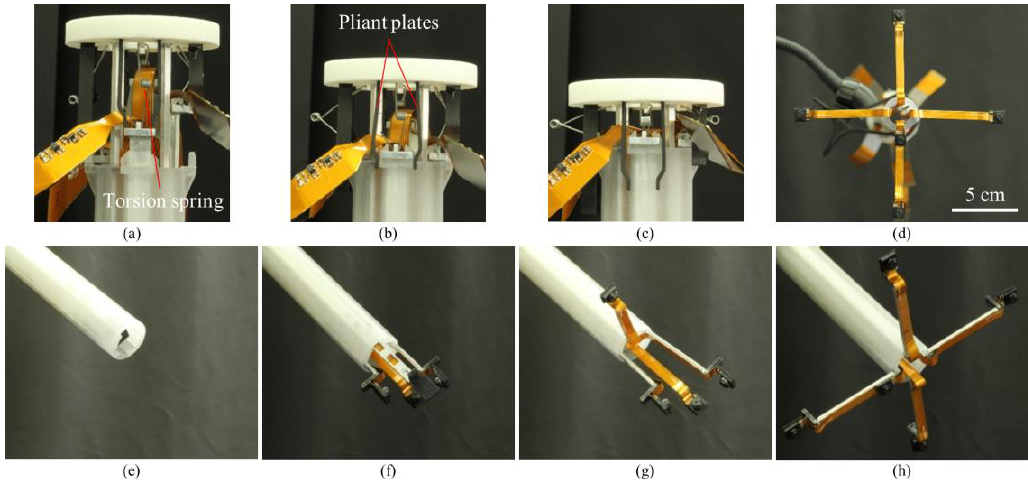
Figure 5. Deployment and retraction of the multiple cameras. ( a – c ) Mechanical system of the push button. Stacked cameras can be deployed and retrieved in a single action within several seconds. ( d ) Camera positions after deployment. ( e – h ) The mechanical system of the foldable camera supports. Four foldable camera supports and five cameras are sequentially deployed and retrieved. The inner side of the port is not occupied by the cameras during operation and allows insertion of surgical instruments.